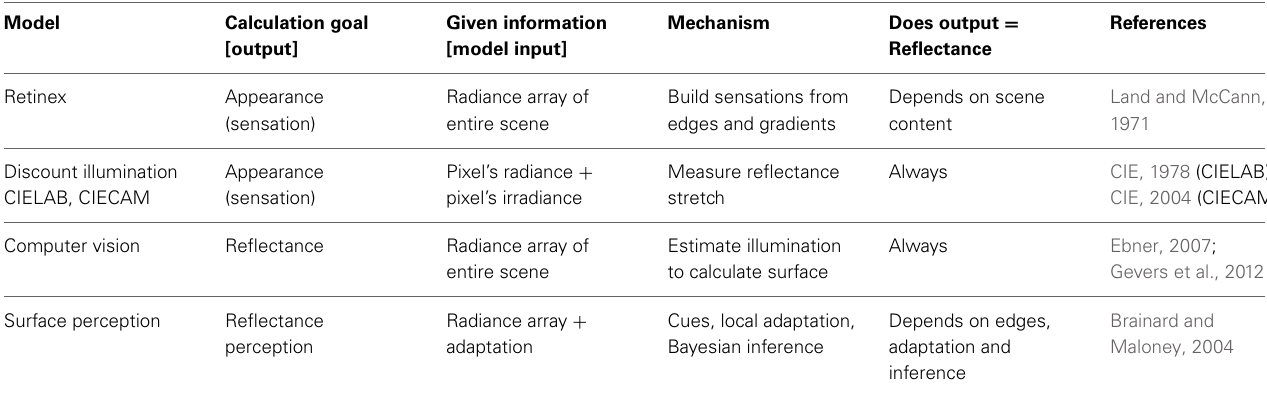
Table 1 | Four classes of color constancy